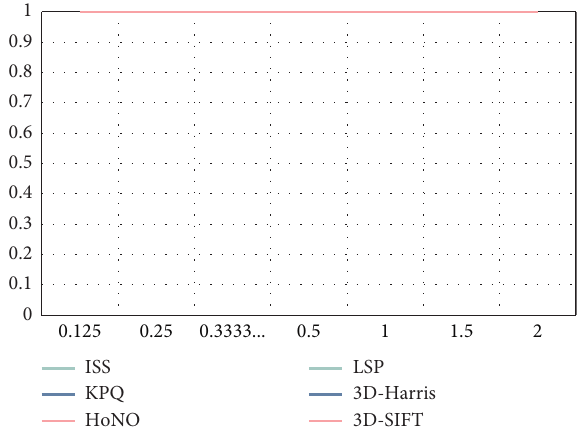
Figure 4: Rotation angle-repetition rate change